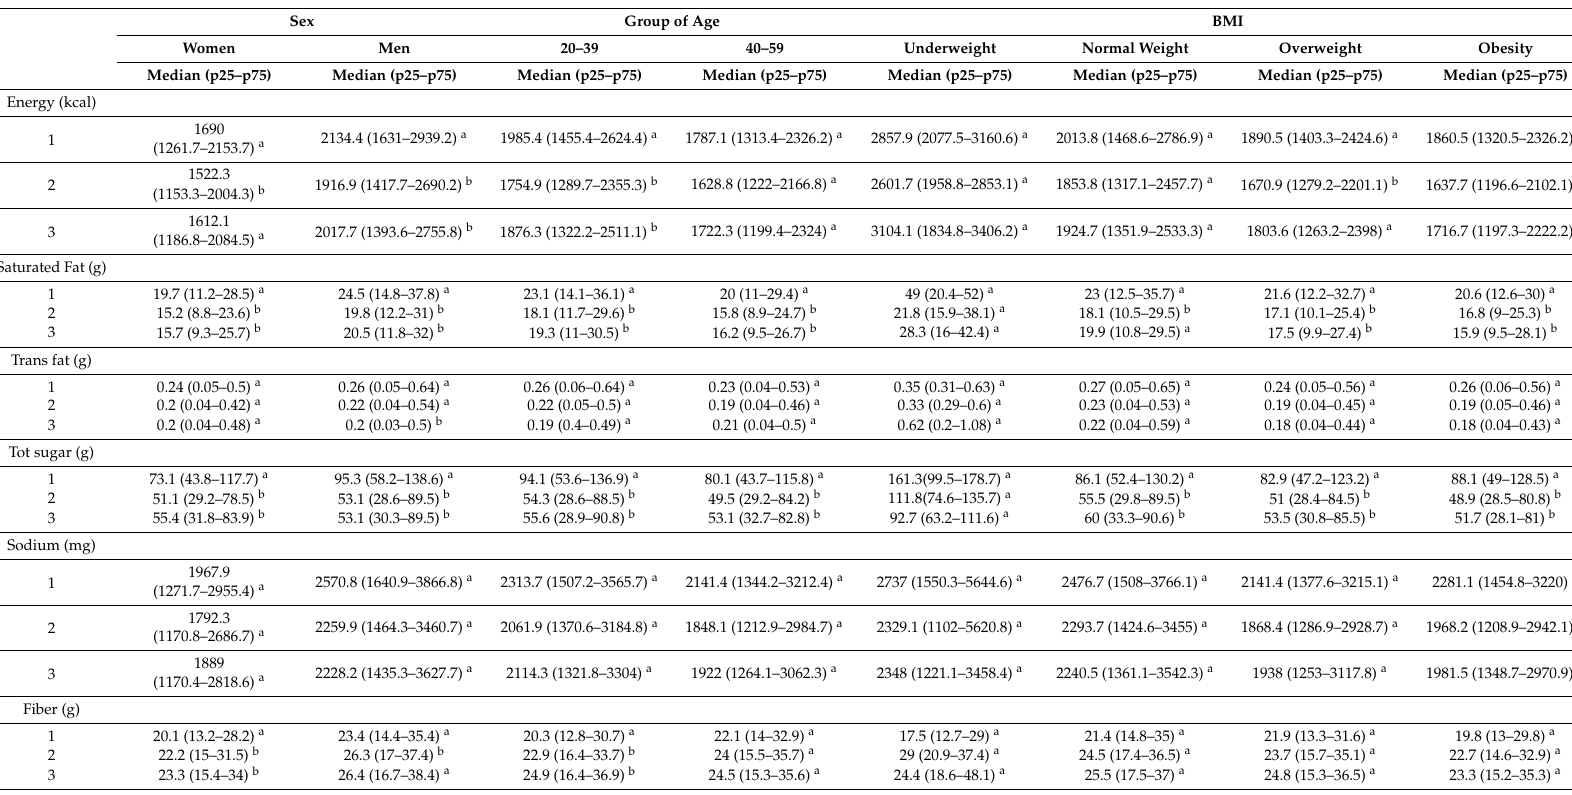
Table A3. Energy and nutrient intake at the national level by sex, age group, and BMI before and after food replacement in the diet of the Mexican adult population + . Mexico, ENSANUT